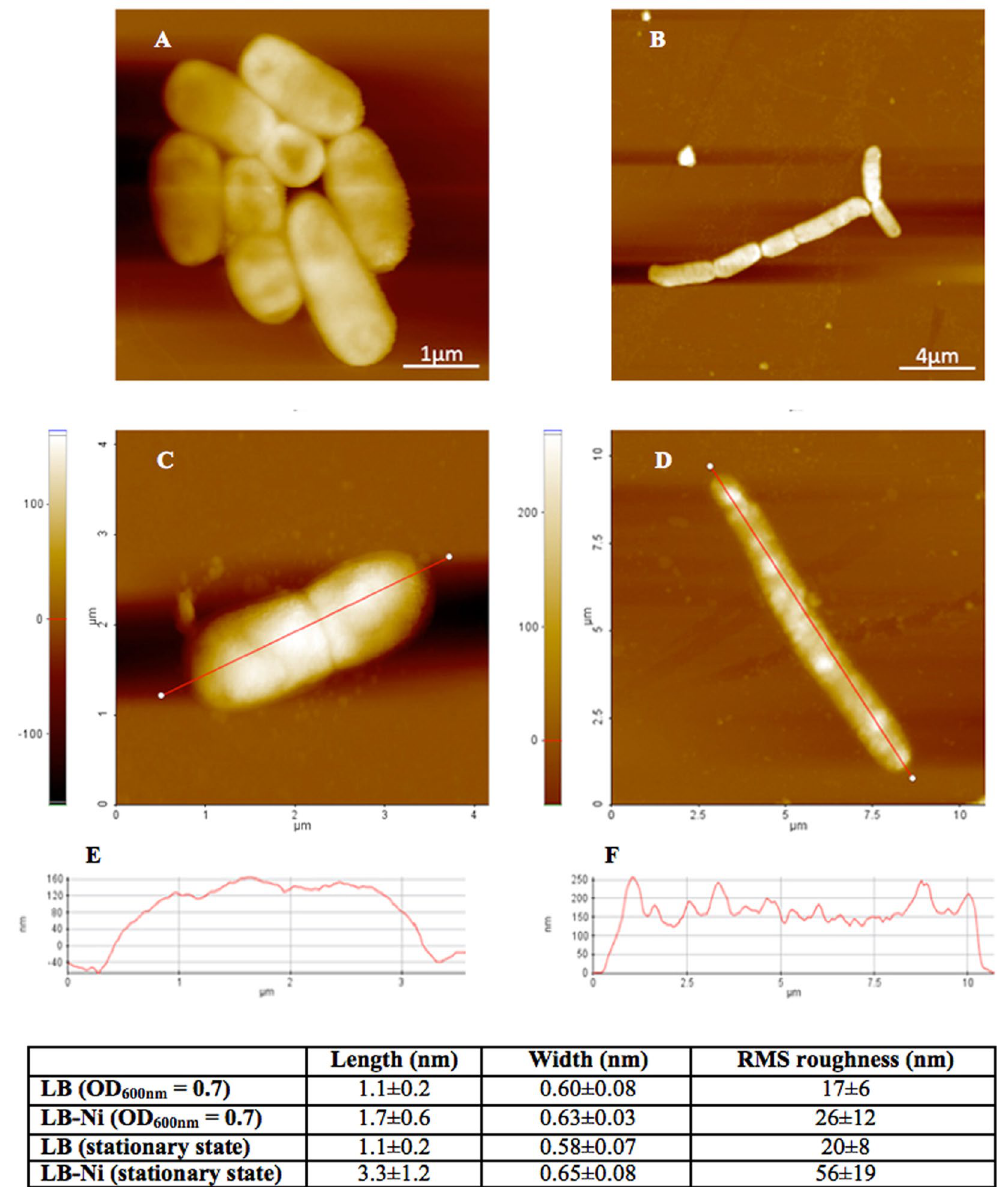
Figure 4. AFM analysis. Comparison of Sphingobium sp. ba1 cell morphology cultured in LB ( A , B ) and LB-Ni ( D , E ) media and harvested at OD 600nm = 0.7 ( A , D ) and at stationary conditions ( B , E ) as obtained by Atomic Force Microscopy (AFM). Height profiles measurements along major cell axes are reported only for cells at stationary state ( C , F ). Measurement values are reported in the inset